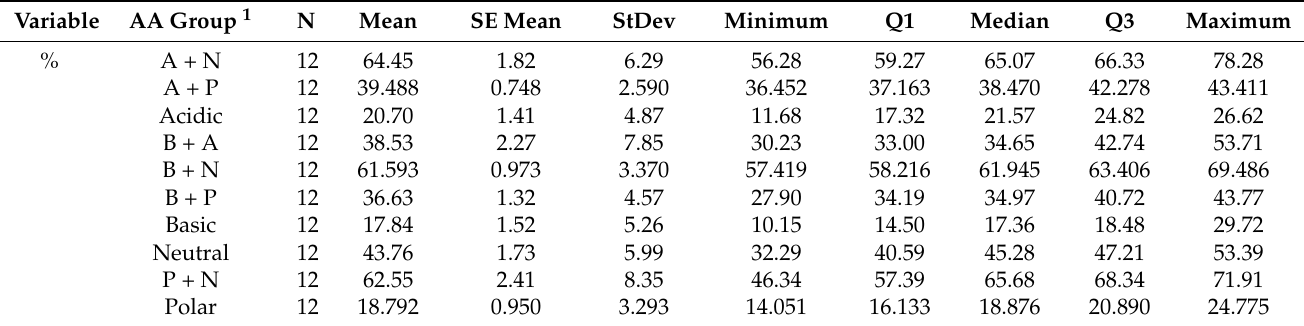
Figure 1. Free amino acid profiles of soy protein following enzymatic hydrolysis under different conditions. 1–12 refer to the individual hydrolysates outlined in Table 1. Table 2. Descriptive statistics for amino acid group data and different hydrolysis procedures using Minitab.